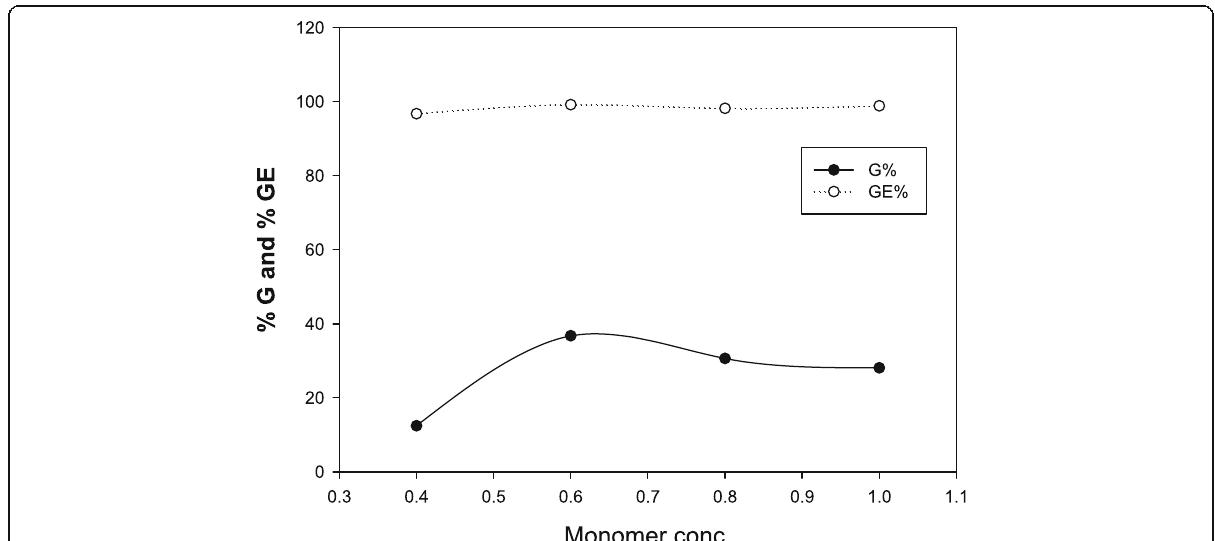
Fig. 1 Effect of initiator concentration APS on grafting percentage (%G) and grafting efficiency (%GE) (Reaction conditions: 1 g CMCh, 3 M styrene, time 2 h, temperature 60 °C)